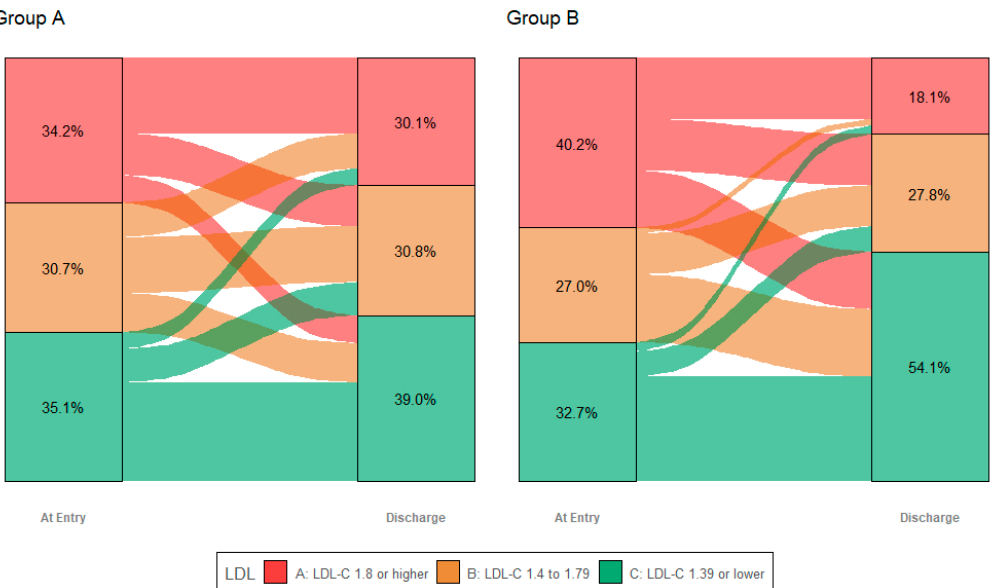
Figure 2. Alluvial plot with LDL-C at CR entry (left) and at discharge (right) for Group A and Group B . The height of the columns represents the number of cases, the vertical bars visualize the target corridors of the ESC/EAS lipid guidelines 2016 and 2019 (green: <1.4 mmol/L, orange: <1–8 mmol/L). Y-Axis also shows the relative number of patients (in %) reaching the target corridors.